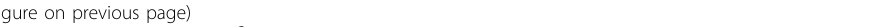
Fig. 3 The level of intracellular Ca 2 + mobilization correlates with PAK1 activity. Active or inactive forms of PAK1 cDNA in the RFP plasmid were transfected into HeLa cells; after an overnight incubation, these cells were loaded with 1 µM Fluo-4 for calcium imaging using confocal microscopy. ER calcium depletion was induced with 1 µM TG, and thereafter, SOCE activation was analyzed after the addition of 2 mM Ca 2 + ( a ). In addition, HeLa cells were pretreated with chemical inhibitors of PAK1, such as 1,4-NHQ (5 or 10 µM, b ) or PF3758309 (5 or 10 nM, c ), before the calcium assay. Additionally, the localization of overexpressed STIM1 and PAK1 was determined after TG treatment and the addition of exogenous calcium by confocal microscopy — the area of colocalization is circled ( d ). PAK1 knockdown cells were established using HeLa cells via transfection of the shDNA plasmid against PAK1, and after western blot analysis of the reduced levels of PAK1 expression, control scramble and PAK1 knockdown cell lines were assayed for calcium mobilization ( e